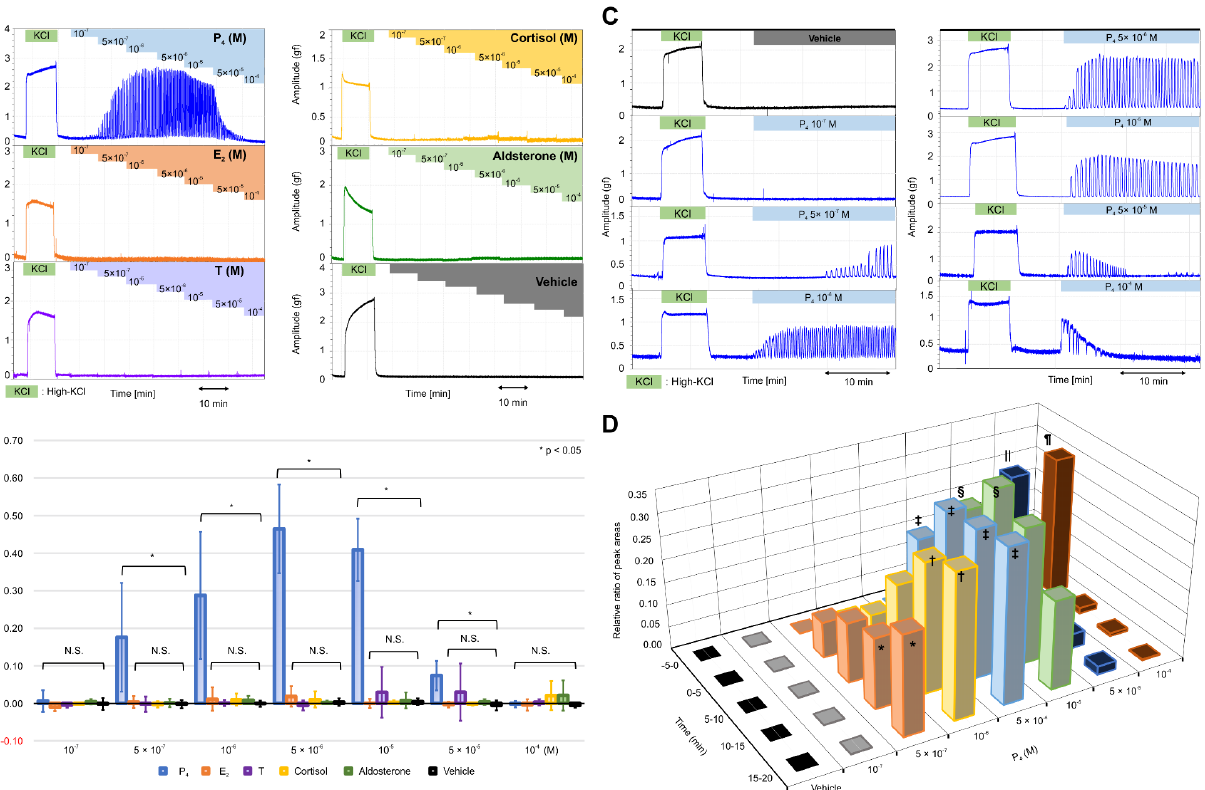
Figure 1. Effects of various natural steroid hormones on the contractile activities in the resting myometrium. ( A ) Representative myograph of six myographs obtained from experiments that used myometrial strips prepared from the uterine tissues of rats at 20 days of gestation. Progesterone (P 4 ), 17 β -estradiol (E 2 ), testosterone (T), cortisol, and aldosterone were added sequentially to a physiological saline solution (PSS) at concentrations of 10 − 7 M–10 − 4 M. ( B ) The relative ratio of the peak area (RRPA) of the progesterone (P 4 ), 17 β -estradiol (E 2 ), testosterone (T), cortisol, aldosterone, and vehicle groups in the resting myometrium. The peak area of high-KCl-induced contractions for 10 min was defined as the reference area. ( C ) Representative myograph of six myographs obtained from experiments that evaluated the effects of single-dose progesterone on the contractile activities in the resting myometrium. Progesterone was added to the PSS at the concentrations of 10 − 7 –10 − 4 M. ( D ) Time- and concentration-dependent changes in the RRPA of the vehicle and progesterone groups at various progesterone concentrations. The peak area of high-KCl-induced contractions for 5 min was defined as the reference area. * p < 0.05, † p < 0.05, ‡ p < 0.05, § p < 0.05, (cid:107) p < 0.05, ¶ p <